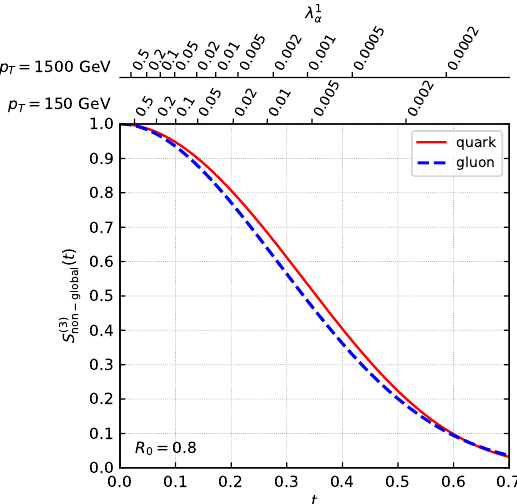
Figure 3 . Sudakov suppression factor associated with the non-global logarithms, S (3) The two curves correspond to the case where the final-state parton is either a quark (solid red) or a gluon (dashed blue). The Sudakov is plotted as a function of the scaled variable t ( L ) (cf. eq. (4.8)). For illustrative purpose, the top axes show the corresponding values of λ 1 two representative jet transverse